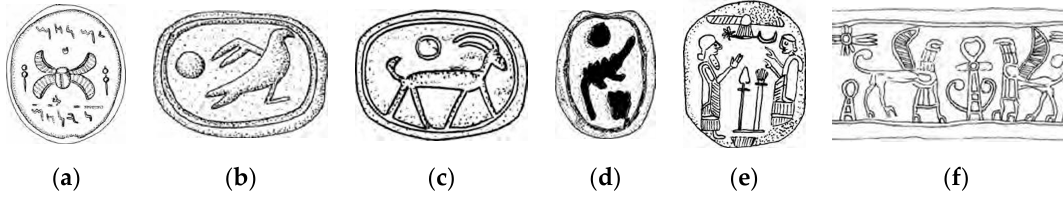
Figure 9. Seals with solar symbolism: ( a ) ʿ Amman 7; ( b ) Tall al-Mazar 7; ( c ) Tall al-Mazar 8; ( d ) Tall al-Mazar 11; ( e ) Tall al-Mazar 14; ( f ) Tall al-Mazar 24.